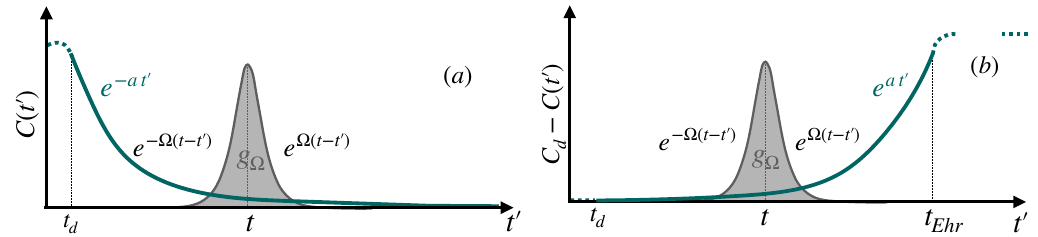
Figure 2: t -FDT on fluctuations C ( t ) that depend exponentially on time. (a) A fluc- tuation function C ( t (cid:48) ) that decays exponentially with a rate a . The dashed line in- dicates the early time (model-dependent) regime. (b) A fluctuation increases expo- (cid:28) t (cid:28) t nentially in time for t with rate a . What happens in the post-Ehrenfest d Ehr times is, again, model-dependent. The competition between the exponential decay of cosh ( Ω t ) and the exponential dependence of C decides which time-interval dom- inates the integral. When the exponents in C become large enough compared to Ω , there is a transition from a small ‘blurring’, to a situation where either early or post- Ehrenfest times dominate. A similar picture holds for the response function R ( t ) . We thus clearly see from the picture that the result of the convolution can be negative only if it is the boundary times that